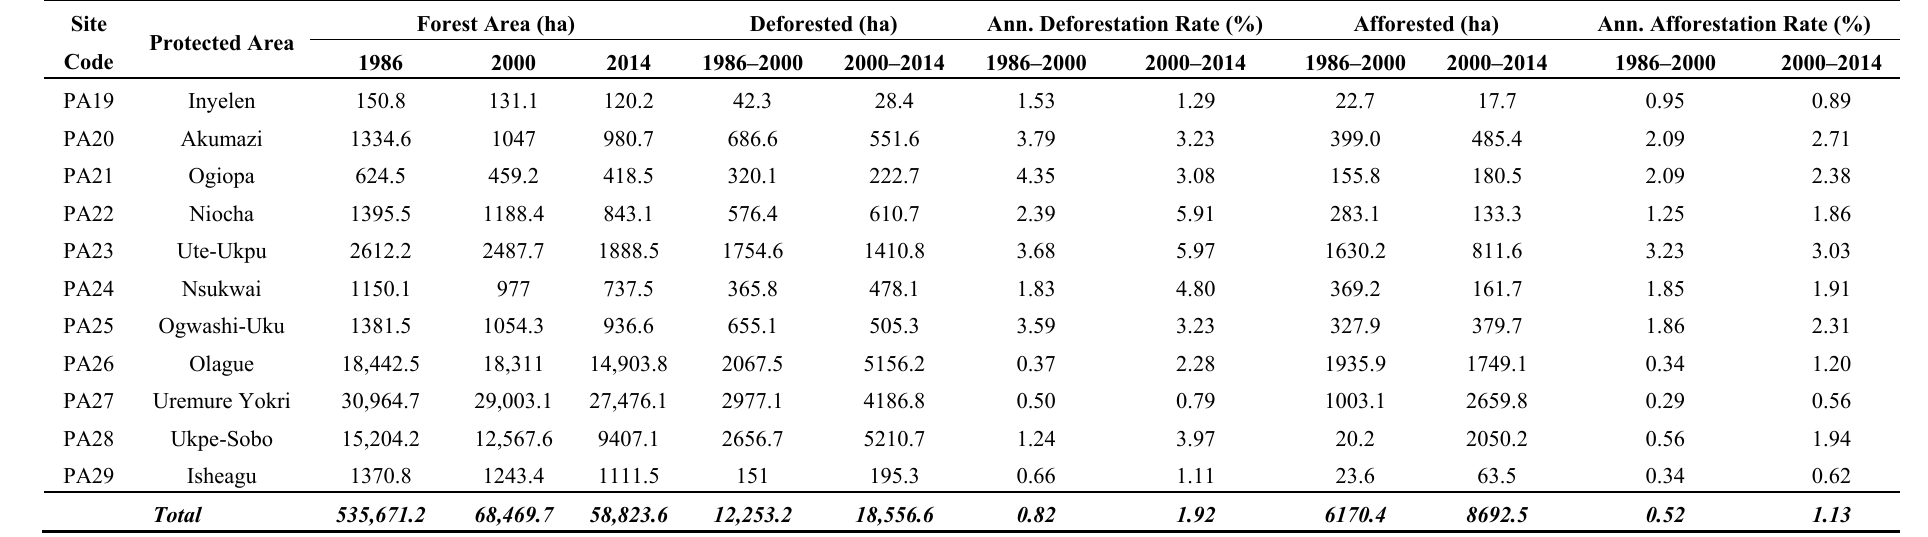
Table 5. Forest transition and annual rates of change for PAs across Delta from 1986 to